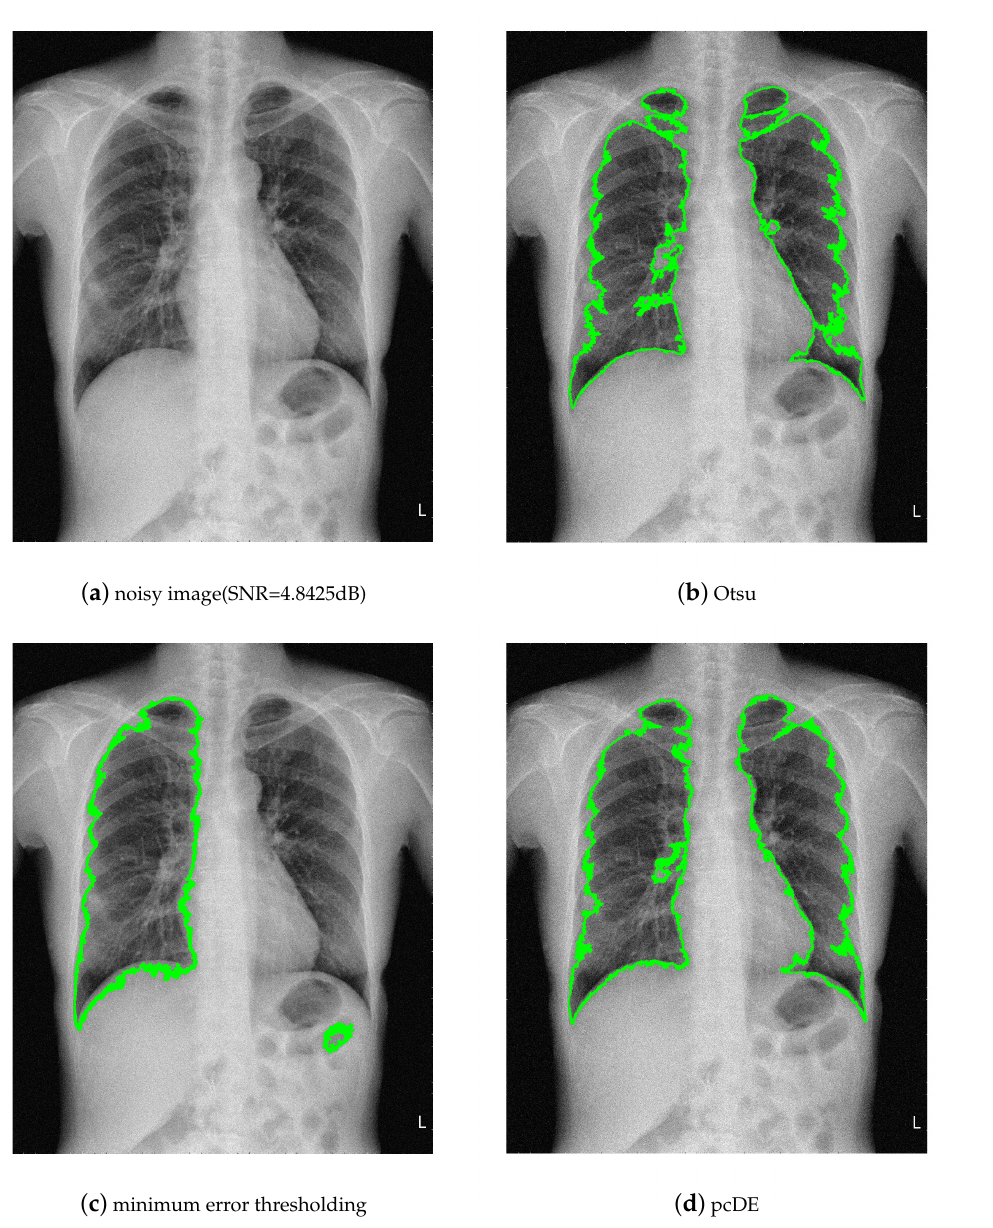
Figure 12. Contour marked image.